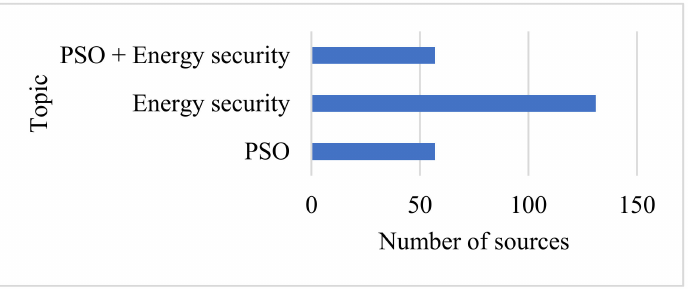
Figure 6. Classification of the selected sources across the topics (designed by the authors).